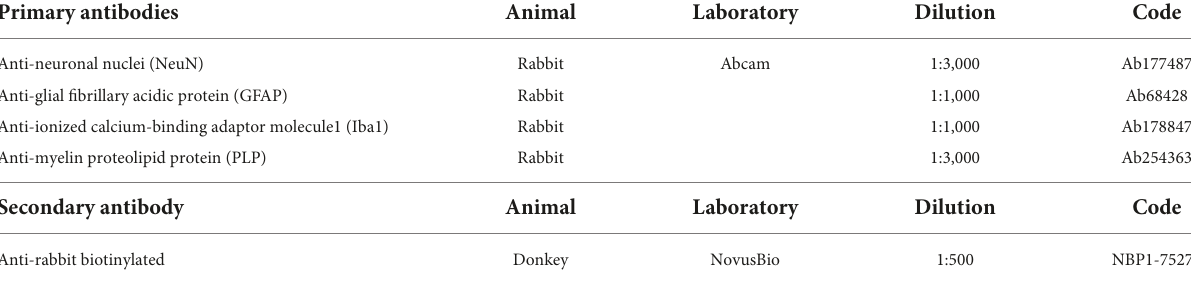
TABLE 3 Immunohistochemistry antibodies. Primary